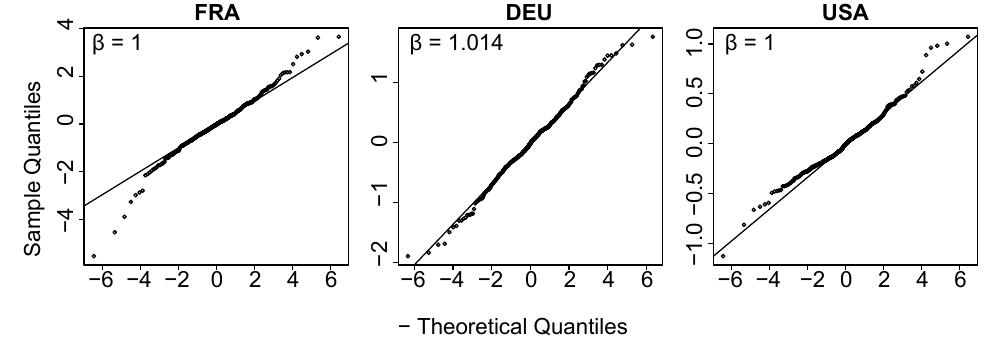
Figure 8. Quantile-quantile plot with France, Germany and the USA comparing ε t , using the festive day correction, with the optimal exponential distribution using the R-package normalp